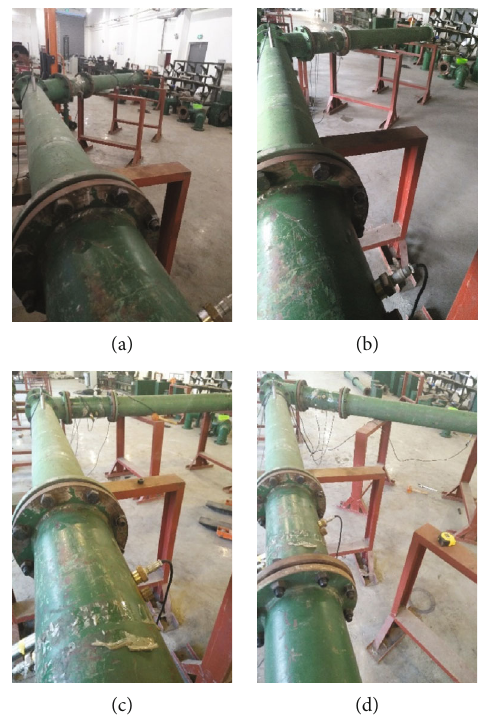
Figure 3: Gas explosion test devices of bend pipes: (a) 30 ° , (b) 60 ° , (c) 90 ° , and (d) 135 ° .